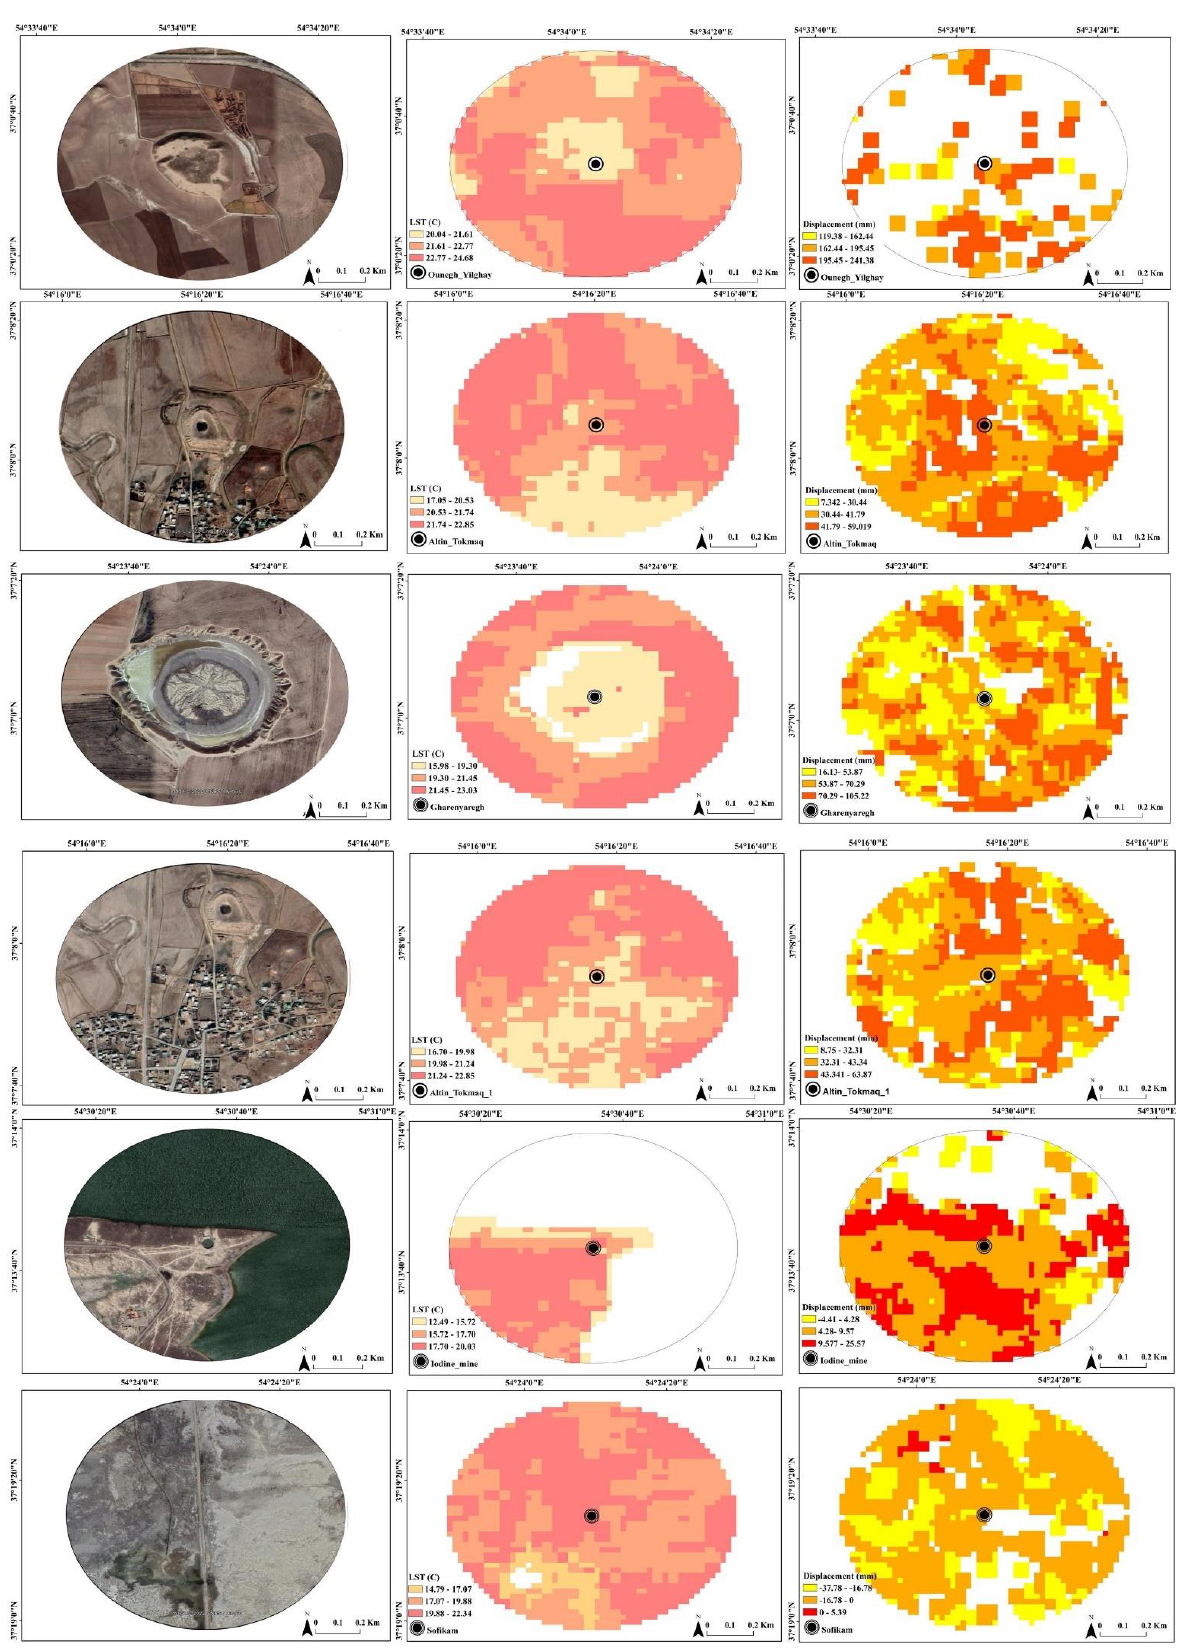
Figure 4 . From Left to right, indicates the mud volcanoes extracted from Google Earth, LST and surface displacement maps within a radius of 500